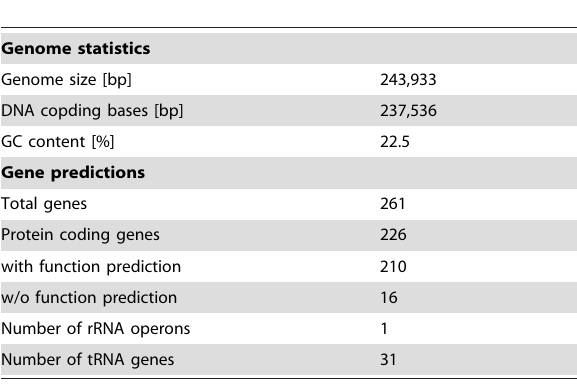
Table 1. General features of the Candidatus Sulcia muelleri DMIN genome.